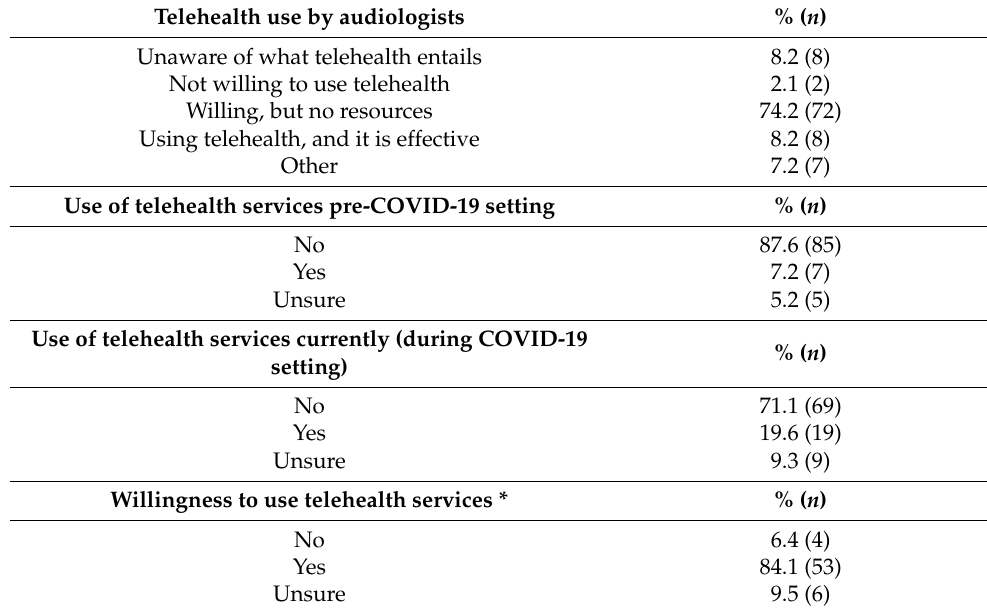
Table 1. Audiologists’ perceptions of telehealth practices within their hospital setting ( n = 97).